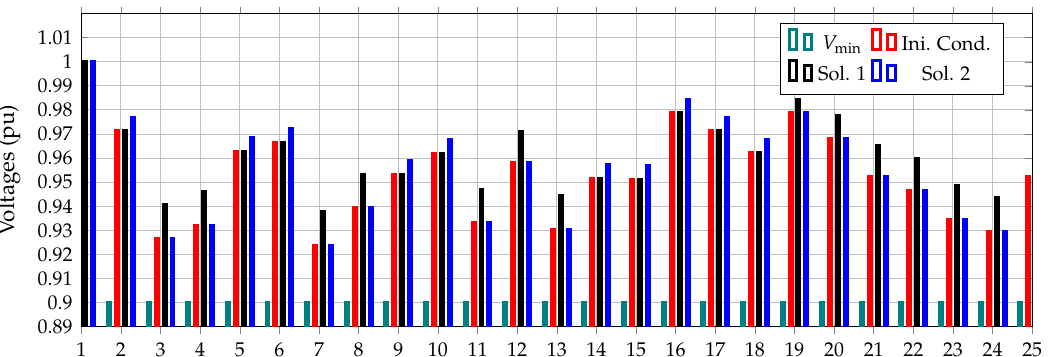
Figure 8. Voltage profiles in phase a for all the solutions reported in Table